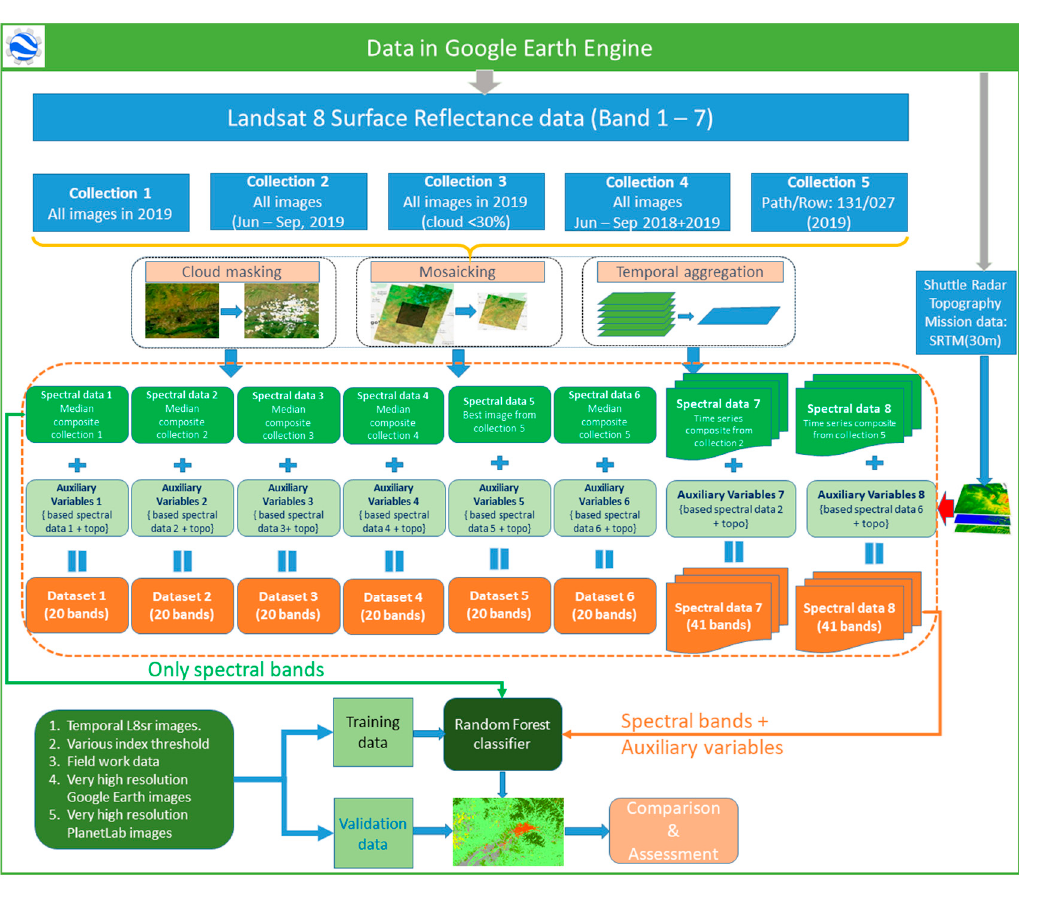
Figure 3. Flowchart of the study. Table 1. The composition of the eight datasets used for classification and comparison.